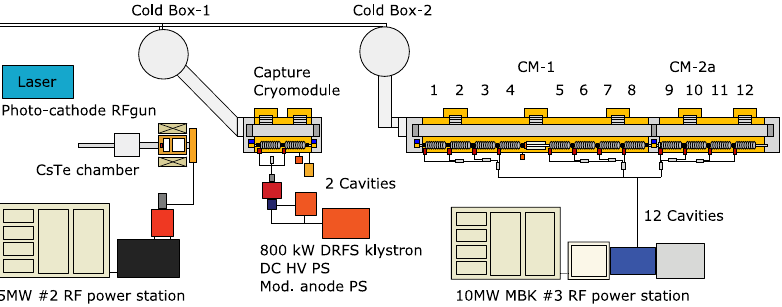
FIG. 4. Layout of the STF. It is composed of a normal conducting photocathode rf gun, two superconducting nine-cell cavities in the capture cryomodule, eight superconducting nine-cell cavities (cavity number 1 – 8) in the cryomodule CM-1, and four superconducting nine-cell cavities in the cryomodules CM-2a (cavity number 9 – 12).